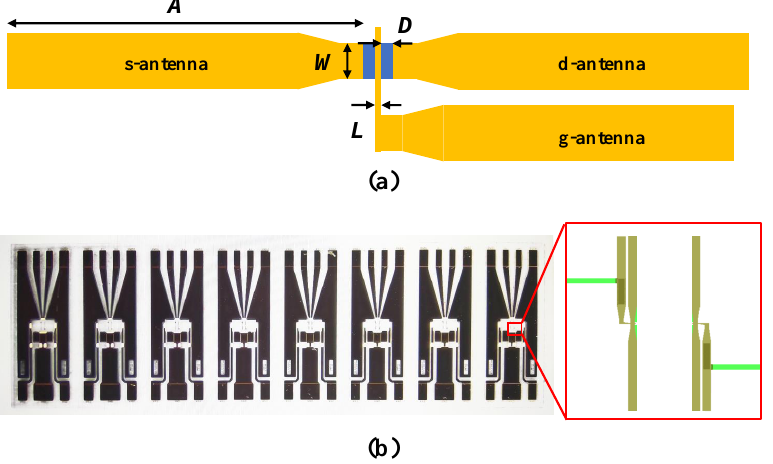
Figure 2. ( a ) The top view of the pixel of the TeraLDA. ( b ) Optical microscope image of the 8-pixel TeraLDA